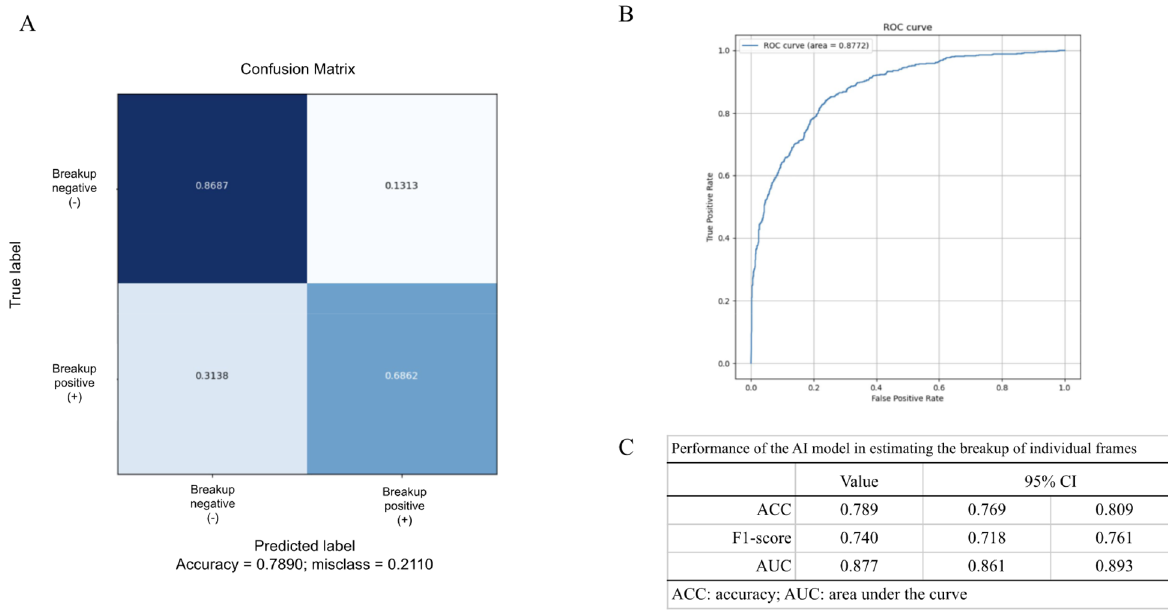
Figure 3. Accuracy of the trained model. ( A ) A confusion matrix of the trained model for the breakup- estimating function from individual frames. ( B ) The receiver operating characteristic curve of the trained model for the breakup-estimating function from the individual frames. ( C ) The accuracy was 0.789 (95% CI 0.769– 0.809), F1-score was 0.740 (95% CI 0.718–0.761), and the area under the curve was 0.877 (95% CI